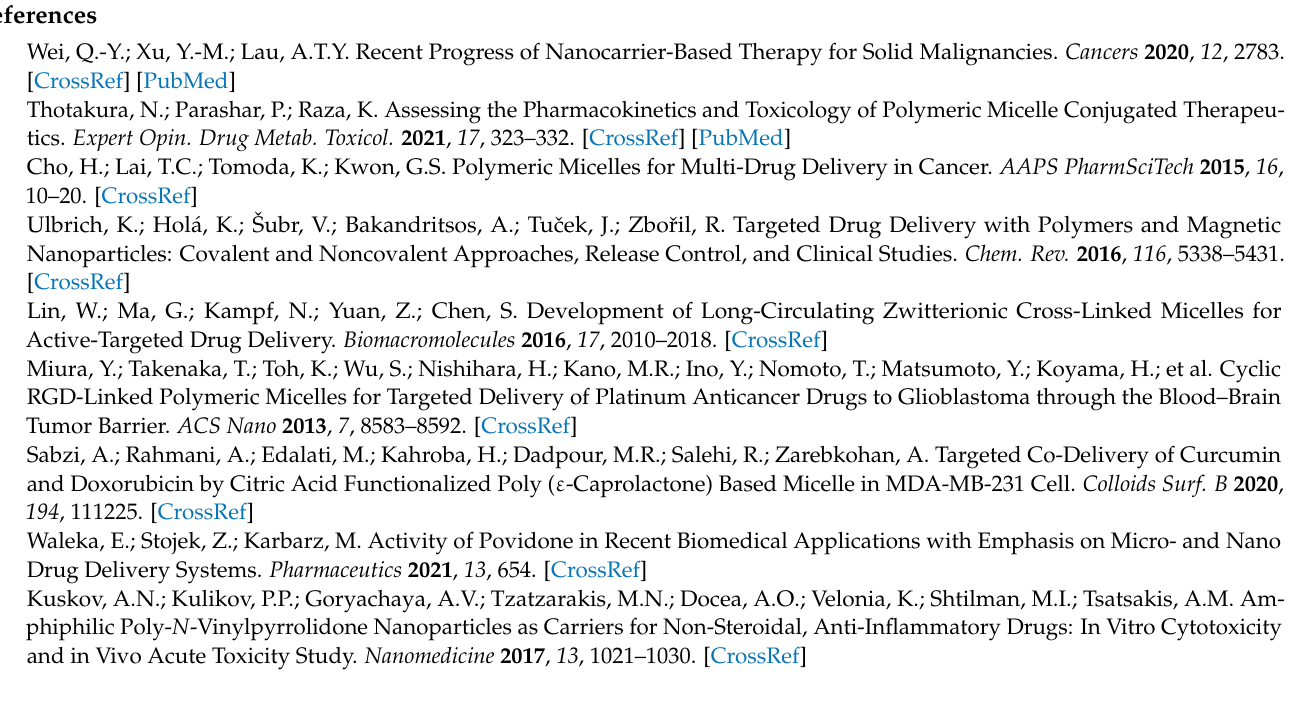
Figure S2: DR5-B/V114C cytotoxic activity in colorectal carcinoma HCT116 cell line. Figure S3: Morphology of 3D tumor spheroids of HCT116 colorectal carcinoma cells after 24 h incubation with P-DR5-B at a concentration corresponding to 100 ng/mL of the DR5-B ligand. Table S1: The values of standard errors of the regression (S) for IC50 of free DR5-B and the P-DR5-B nanoparticles in 2D and 3D in vitro